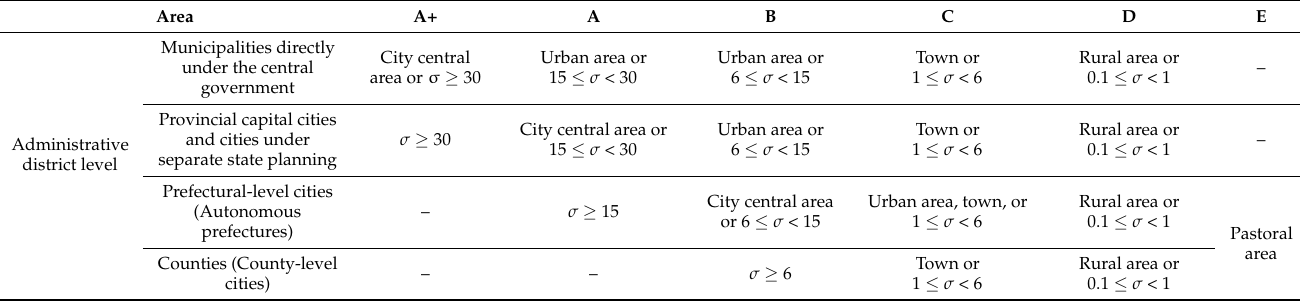
Table 4. Classification of power supply areas [50].